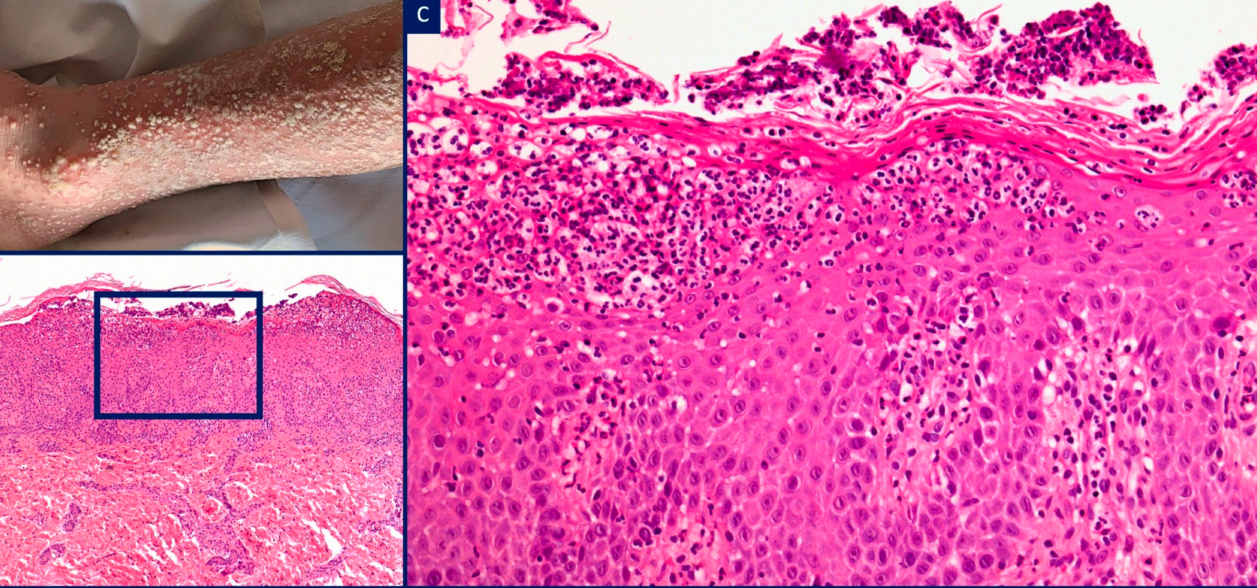
Figure 5. Pustular-psoriasis in deficiency of IL-36 receptor antagonist syndrome (DITRA): ( A ) 5-year-old boy with an erythrodermic eruption showing confluent, non-follicular, aseptic pustules on an erythematous background; ( B ) H&E, × 4. Psoriasiform epidermal hyperplasia with aggregates of subcorneal and intra-epidermal neutrophils; ( C ) H&E, × 10. Spongiform pustules, neutrophils in a parakeratotic stratum corneum, and a neutrophilic infiltrate in the papillary dermis. Courtesy of Deborah